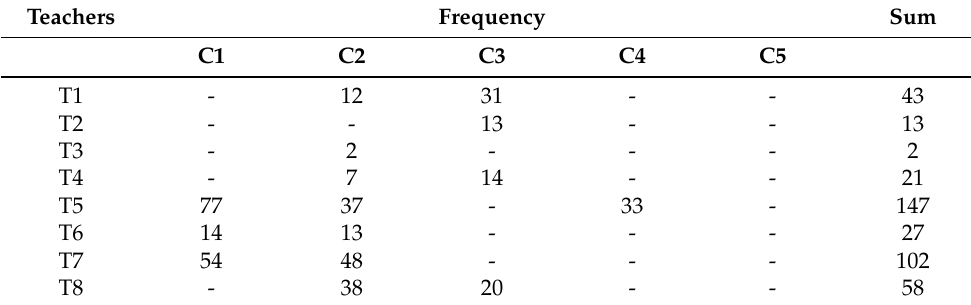
Table 6. Frequency of use of the CT Criteria by teachers in STEM